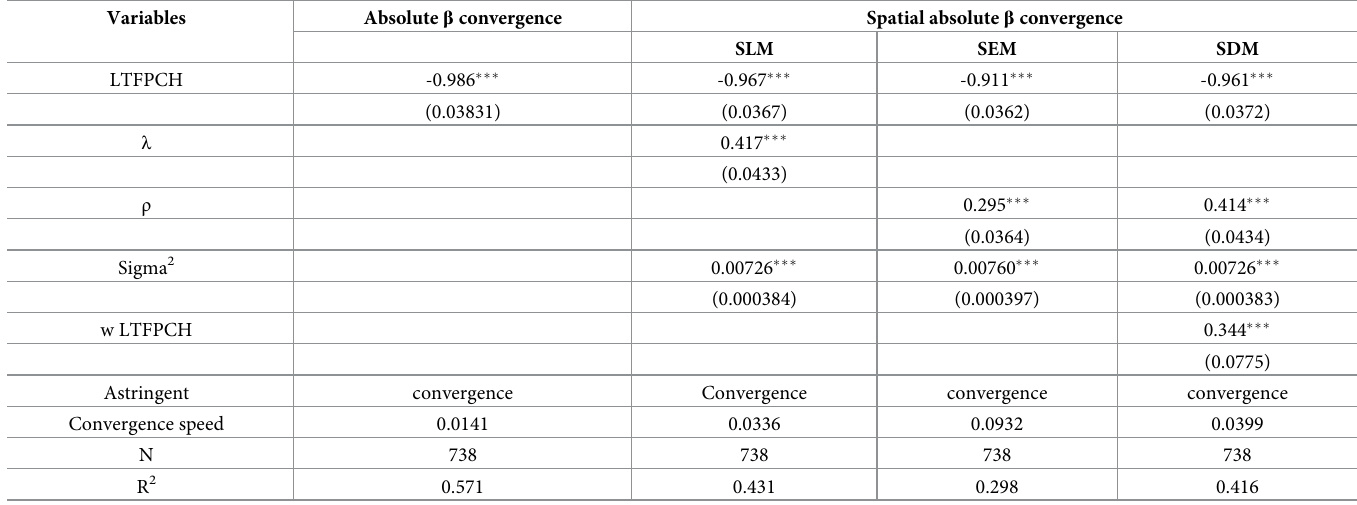
Table 7. Results of the spatial convergence model of AGTFP in the YRD